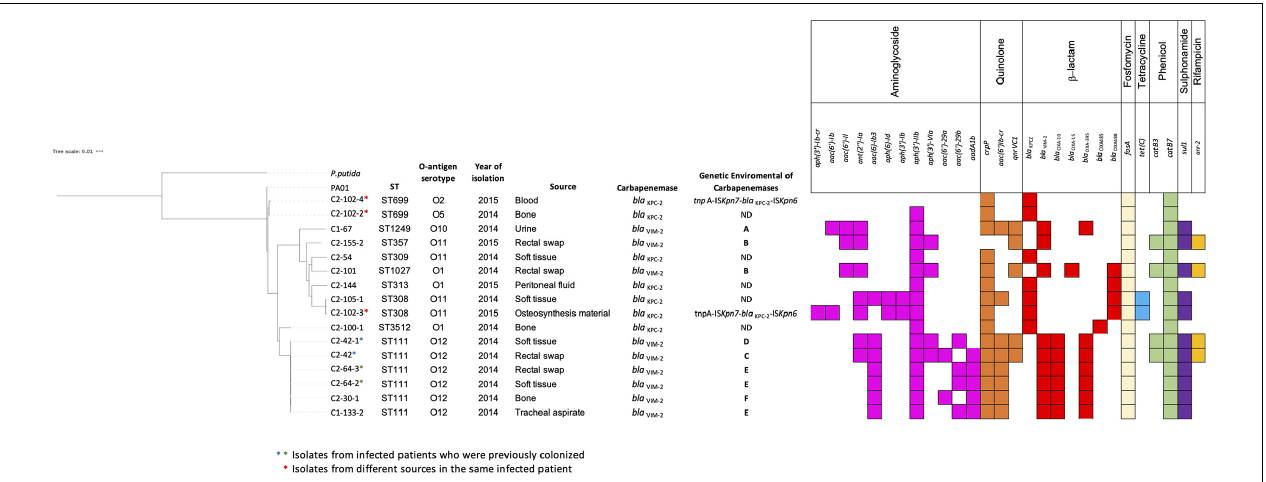
FIGURE 1 | Phylogenetic tree showing the genetic relationships among isolates of Pseudomonas aeruginosa ( n = 16). Isolates were characterized by ST, O-antigen serotype, and year of isolation. We indicate carbapenemases genes bla KPC − 2 or bla VIM − 2 and the genetic environment identified in each isolate. Resistance determinants to aminoglycoside, quinolone, β -lactam, fosfomycin, tetracycline, phenicol, sulfonamide, and rifampicin are grouped and indicated by color (color box indicates presence; blank indicates absence).